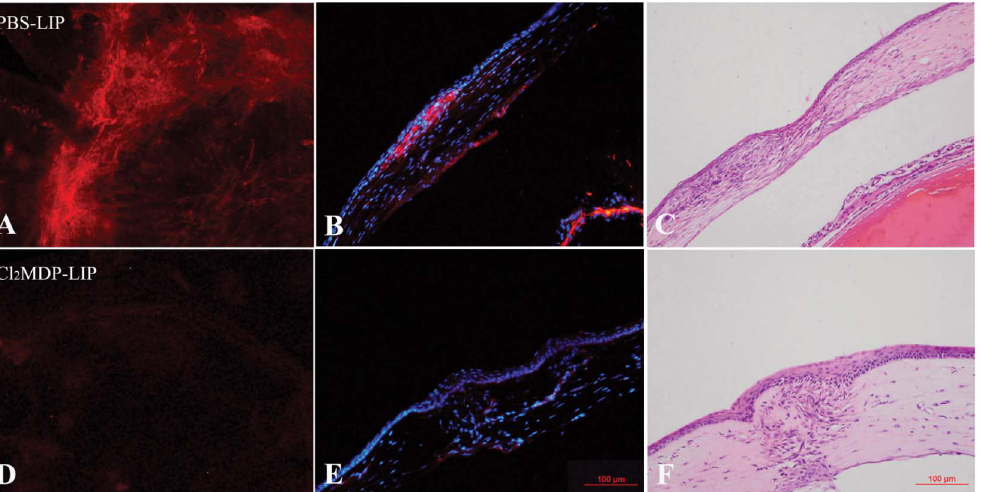
Figure 3. Effect of macrophage depletion on myofibroblast differentiation. Corneal flat mount staining after 14 days of penetrating keratoplasty showed that a -SMA was strongly expressed in the junction area between the graft and recipient cornea (A) and parallel to the corneal surface (B, C) in the PBS-LIP-injected mice, while in the Cl 2 MDP-LIP-treated mice, a -SMA expression was significantly lower (D), and the fibers in the junction area were more disorganized than in the control mice